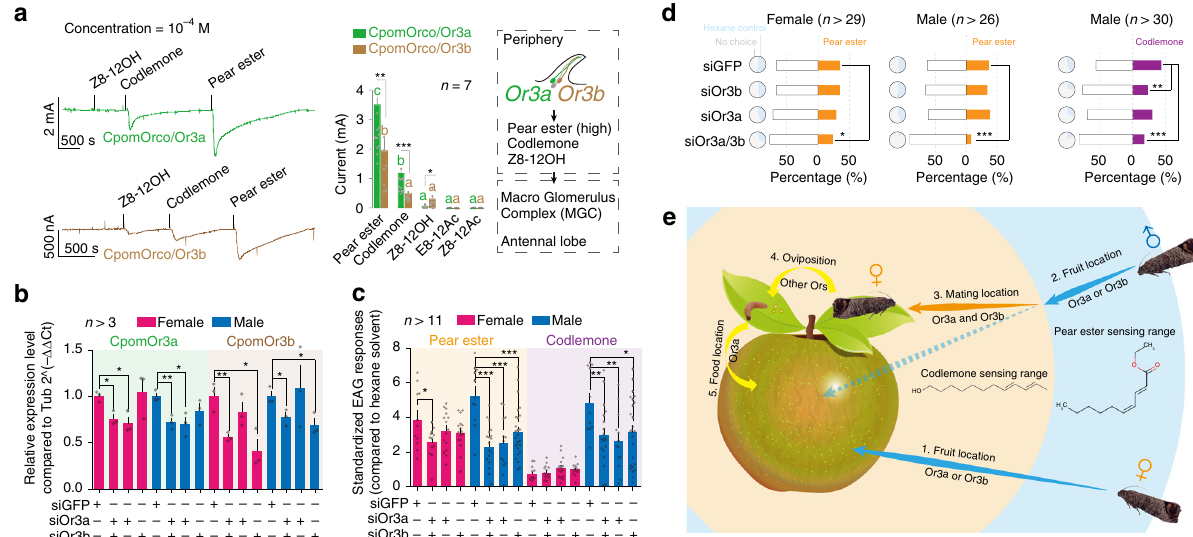
Fig. 4 Functional demonstration of CpomOR3a/CpomOR3b in pear ester and codlemone olfactory reception of the codling moth, Cydia pomonella . a Comparison of CpomOR3a and CpomOR3b responses to different chemical components with Xenopus expression system. Example traces of CpomOR3a / CpomORco and CpomOR3b / CpomORco injected Xenopus oocytes are shown respectively, with current elicited by Z8-12OH, codlemone, and pear ester solutions at 10 − 4 M concentration. Lower case letters indicate signi fi cant differences (ANOVA and Tukey HSD, F 4, 45 = 161.8, P < 0.0001), or = 22.3, P < 0.0001). * indicates signi fi cant differences (Student ’ s t test, pear ester: CpomOR3b / CpomORco injected oocytes (ANOVA and Tukey HSD, F 4, 45 t = 3.6, P = 0.0027; codlemone: t = 4.2, P = 0.0008; Z8-12OH: t = 2.5, P = 0.0235). Error bars indicate + SEM. ( b ) Quantitative PCR tests for RNAi 15 15 17 strains. Data were calculated based on the 2 − ΔΔ Ct method with normalization to Cpom β -tubulin . * indicates signi fi cant in fl uences (Student ’ s t test, CpomOR3a , female, siOR3a/b: P = 0.0118, siOR3a: P = 0.0181; male, siOR3a/b: P = 0.0019, siOR3a: P = 0.0273 (one-tail); CpomOR3b , female, siOR3a/b: P = 0.0090, siOR3b: P = 0.0171; male, siOR3a/b: P = 0.0284, siOR3b: P = 0.0035). Error bars indicate + SEM. c Electroantennogram (EAG) results with RNAi strains to pear ester and codlemone. * indicates signi fi cant decrease (Student ’ s t test, pear ester, female, siOR3a/siOR3b: t 21 = 2.4, P = 0.028; pear ester, male, siOR3a/siOR3b: t 28 = 5.3, P < 0.0001, siOR3a: t 22 = 4.1, P = 0.0004, siOR3b: t 35 = 3.7, P = 0.0007; codlemone, male, siOR3a/siOR3b: t 28 = 2.8, P = 0.009, siOR3a: t 22 = 3.1, P = 0.005, siOR3b: t 35 = 2.5, P = 0.018). Error bars indicate + SEM. d Y -tube assays of RNAi strains. Distributions of counts among choosing of tested chemicals, hexane, and no choice were compared between each injected strain with siGFP strain by chi-square test. Bar charts indicate proportions of counts between positive choice (either codlemone or pear ester) and negative (no choice and hexane control). * indicates signi fi cant differences between current treatment with siGFP strain (pear ester, female, siOR3a/siOR3b: χ = 9.5, P = 0.0084; pear ester, male, siOR3a/ siOR3b: chi = 24.4, P < 0.0001; codlemone, male, siOR3a/siOR3b: χ = 47.4, P < 0.0001, siOR3b: χ = 10.5, P = 0.0053). e Schematic illustration showing predicted OR3a and OR3b mediated behaviors in C. pomonella . Step 1: female adults locate fruits and fi nd mating sites on leaves. Step 2: male adults locate fruits as potential mating sites from a long distance. Step 3: male adults locate females in a close distance via codlemone sensing process. Steps 4 and 5: oviposition of females and food location of newly hatched larvae via OR3a detection of pear ester. Source data are provided as a Source Data fi